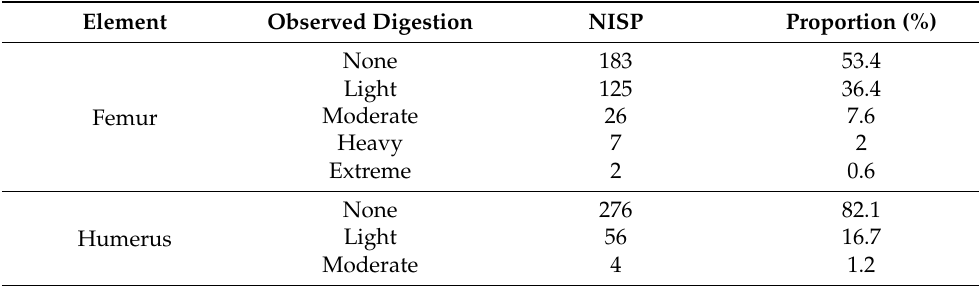
Table 5. Observed humeri and femora digestion across the assemblage. Data presented disaggregated by